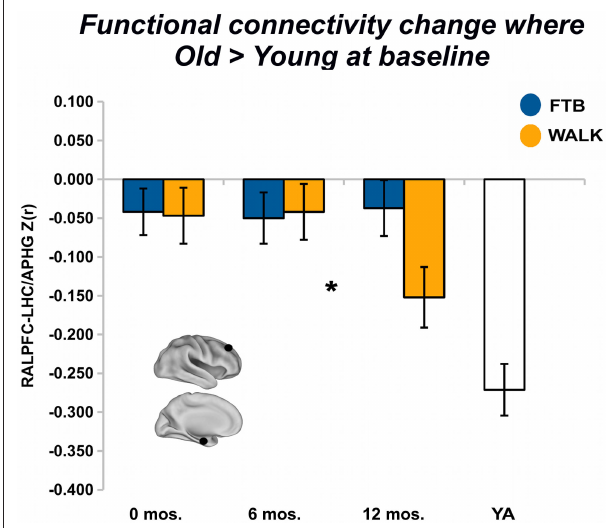
FIguRe 4 | exercise training-related changes in functional connectivity in regions where old started greater than young. Significant effects, from FE network, visualized by plotting marginal group means from the analysis at the corresponding time point (error bars represent 1 + standard error of the marginal mean); * p < 0.05. Refer to Table 4 for anatomical description and MNI coordinates of ROIs represented by black circles. For all brains, R = R and L = L.